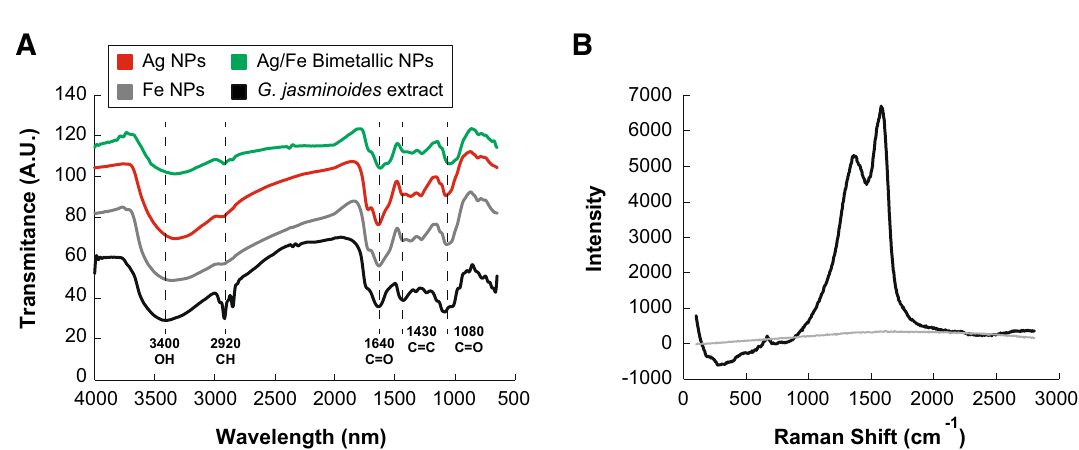
Figure 2. Fourier Transform Infrared (FT-IR) spectra ( A ) of silver (Ag), iron (Fe) nanoparticles, and Ag-Fe bimetallic nanoparticles synthesized using an aqueous extract from leaves of Gardenia jasminoides and the RAMAN spectra of the ( B ) aqueous extract from leaves of Gardenia jasminoides